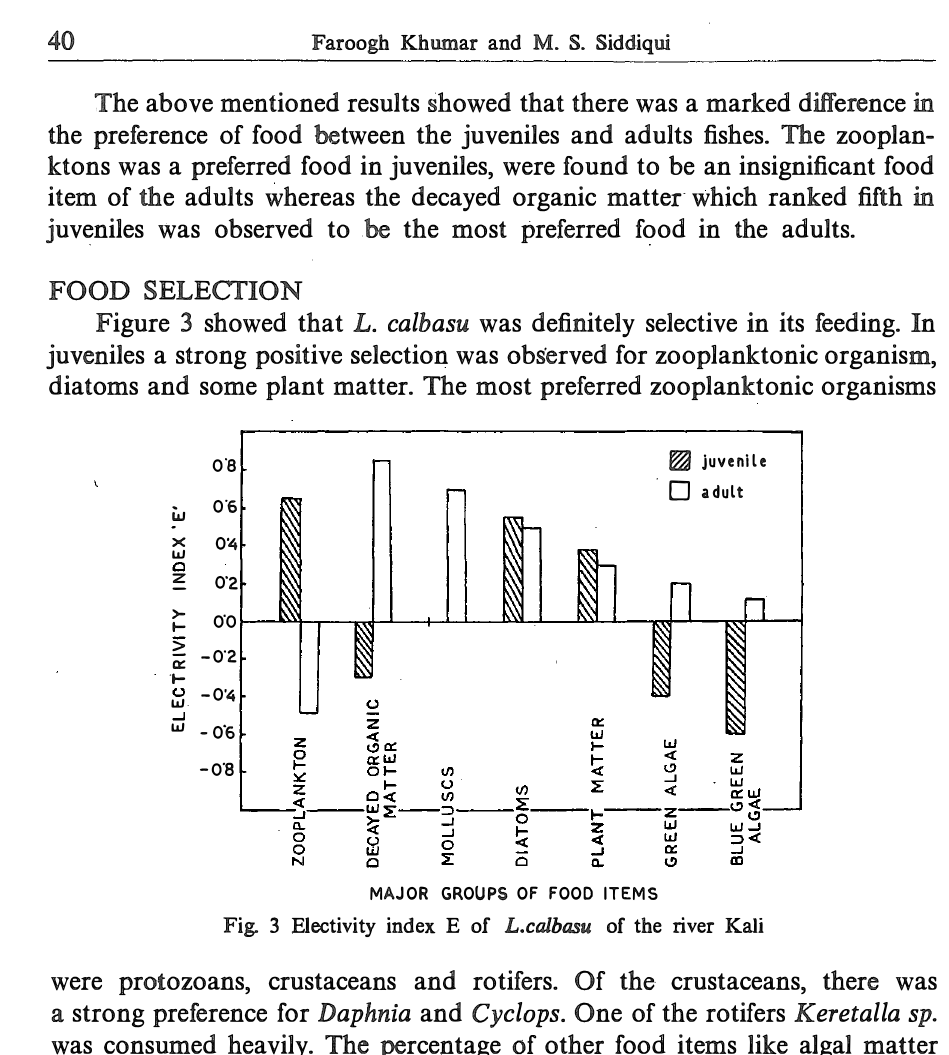
Fig. 3 Electivity index E of L.calbasu of the river